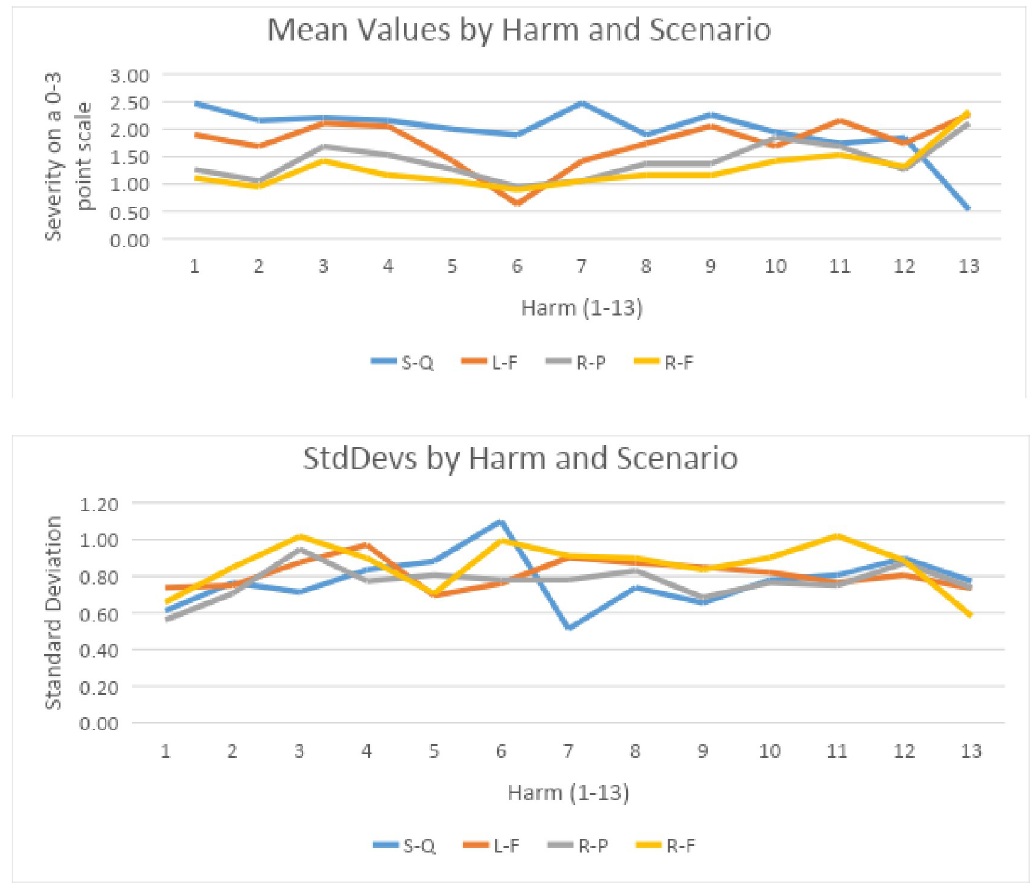
Fig 5. Means and standard deviations for 4-point assessments (0–3) by harm and